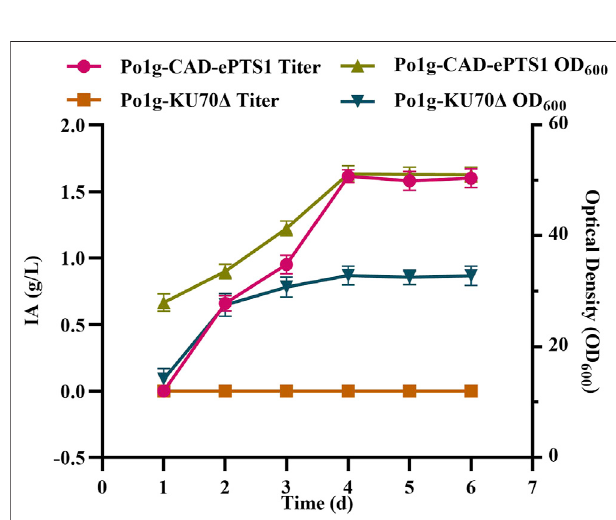
FIGURE 4 | IA production in Y. lipolytica strains expressing the CAD- ePTS1 gene. The titer of IA and biomass were determined by shaking fl ask fermentation of Po1g-CAD-ePTS1 strain and control strain Po1g in YPO culture. All values presented are the mean of three biological replicates ±